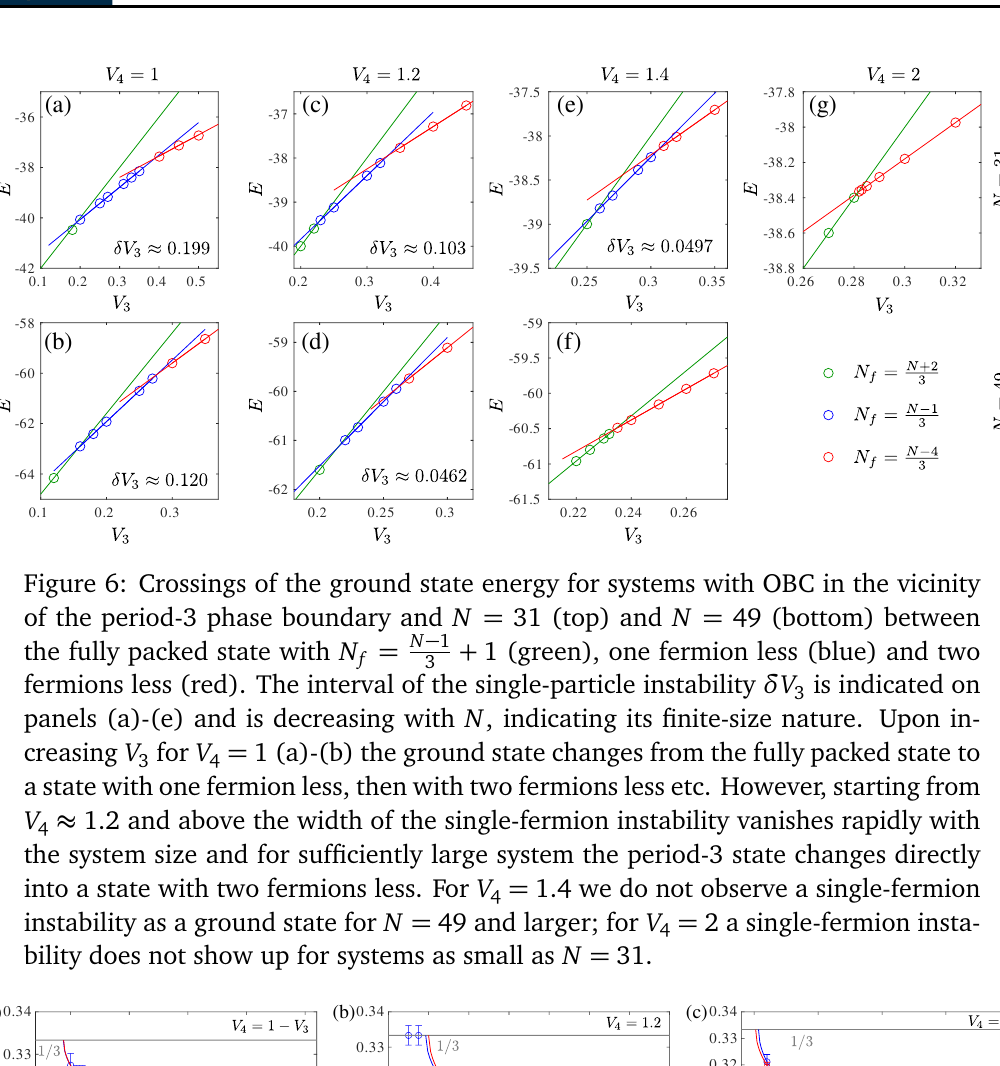
along (a) an oblique 3 = 1.2 and (c) V = 2. Solid 4 4 as a fitting parameter 3